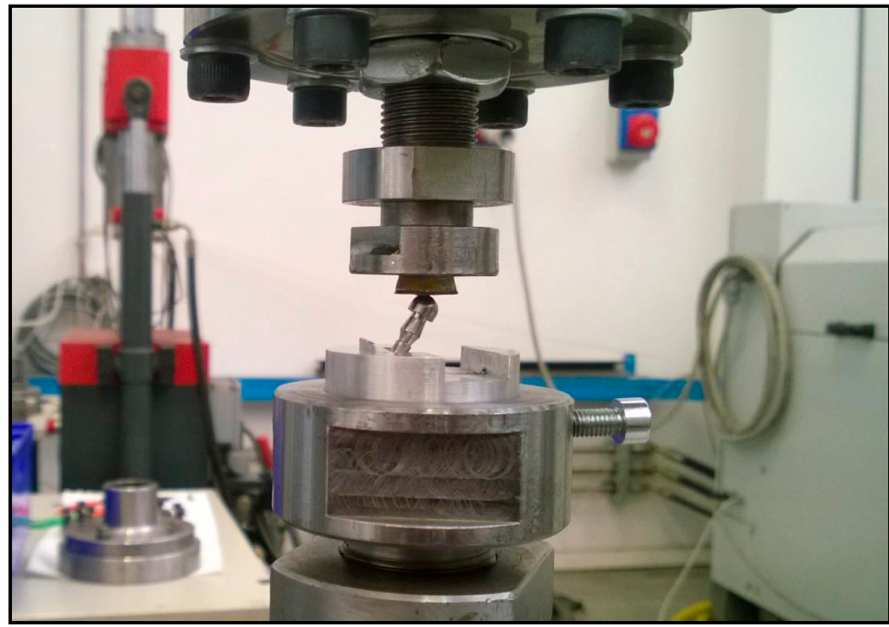
Figure 4. Test configuration used during static characterization.